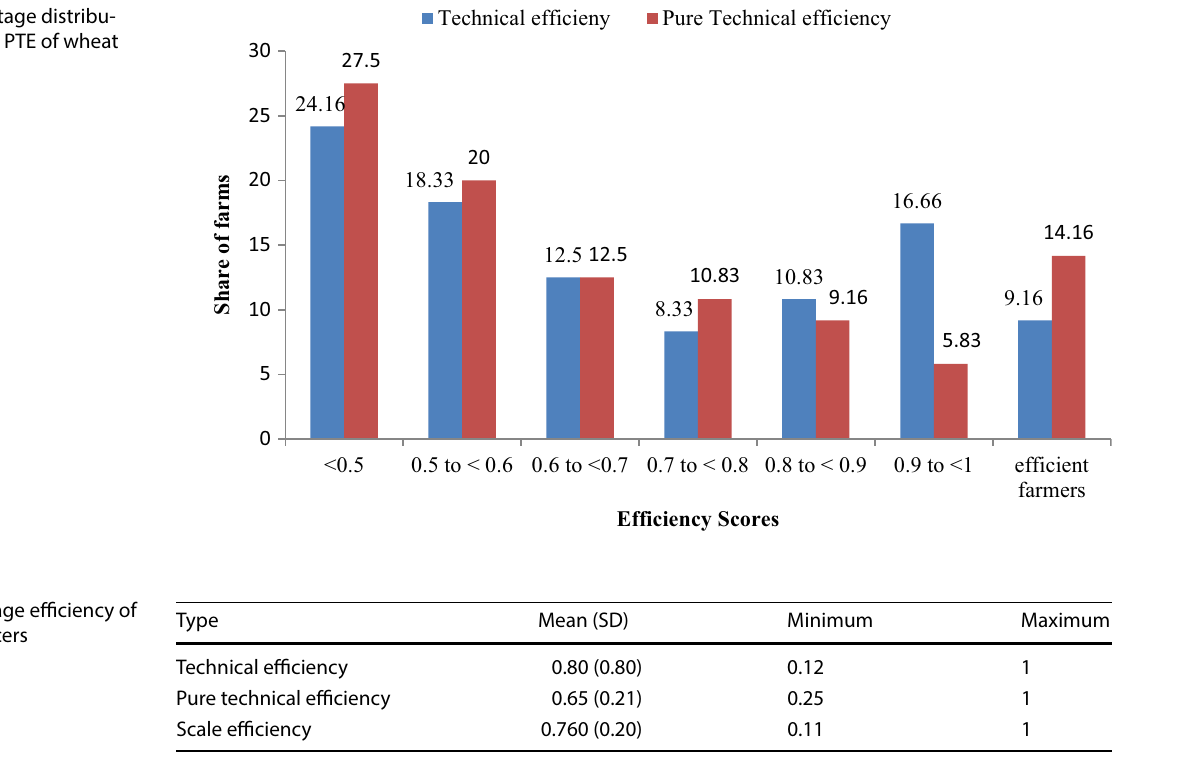
Fig. 2 Percentage distribu- tion of TE and PTE of wheat